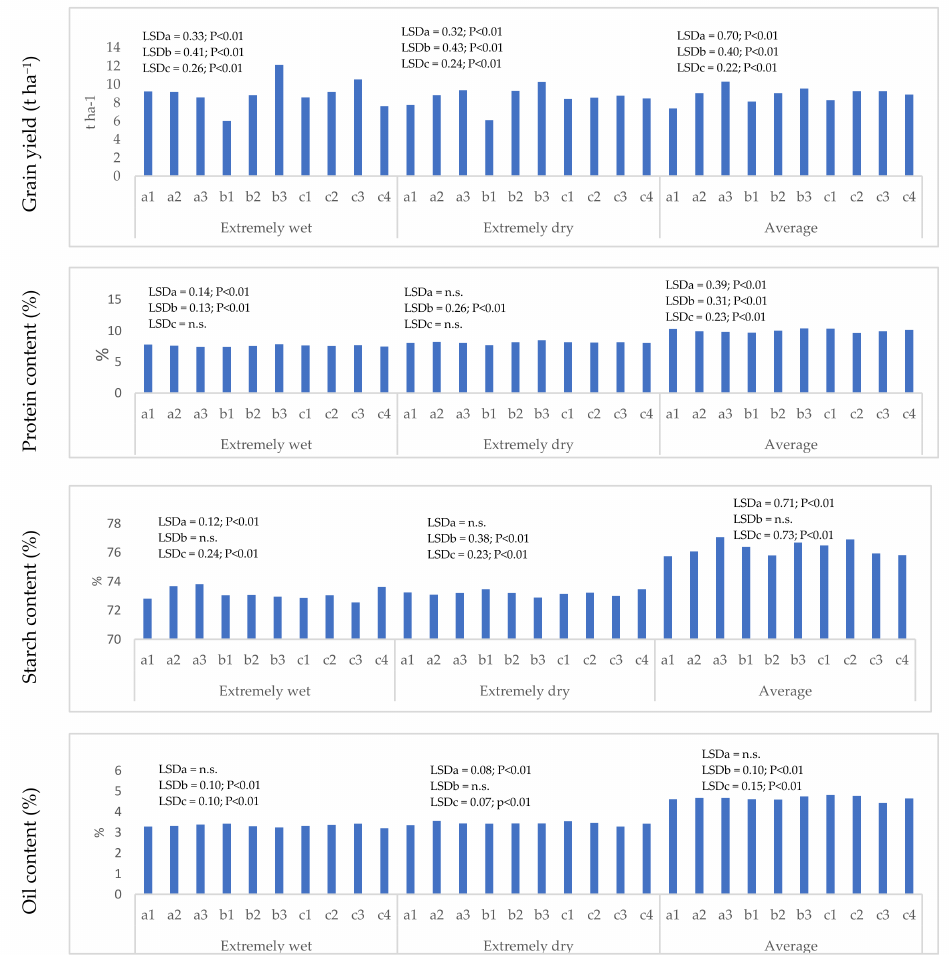
Figure 6. Averages and significances (ANOVA) of the GY, protein, starch, and oil content across the irrigation (a1 = rainfed, a2 = 60–100% field capacity (FC), and a3 = 80–100% FC), N fertilizer rate (b1 = 0 kg N ha − 1 , b2 = 100 kg N ha − 1 , b3 = 200 kg N ha − 1 ), and maize hybrid (c1 = OSSK596, c2 = OSSK617, c3 = OSSK602, and c4 = OSSK552)